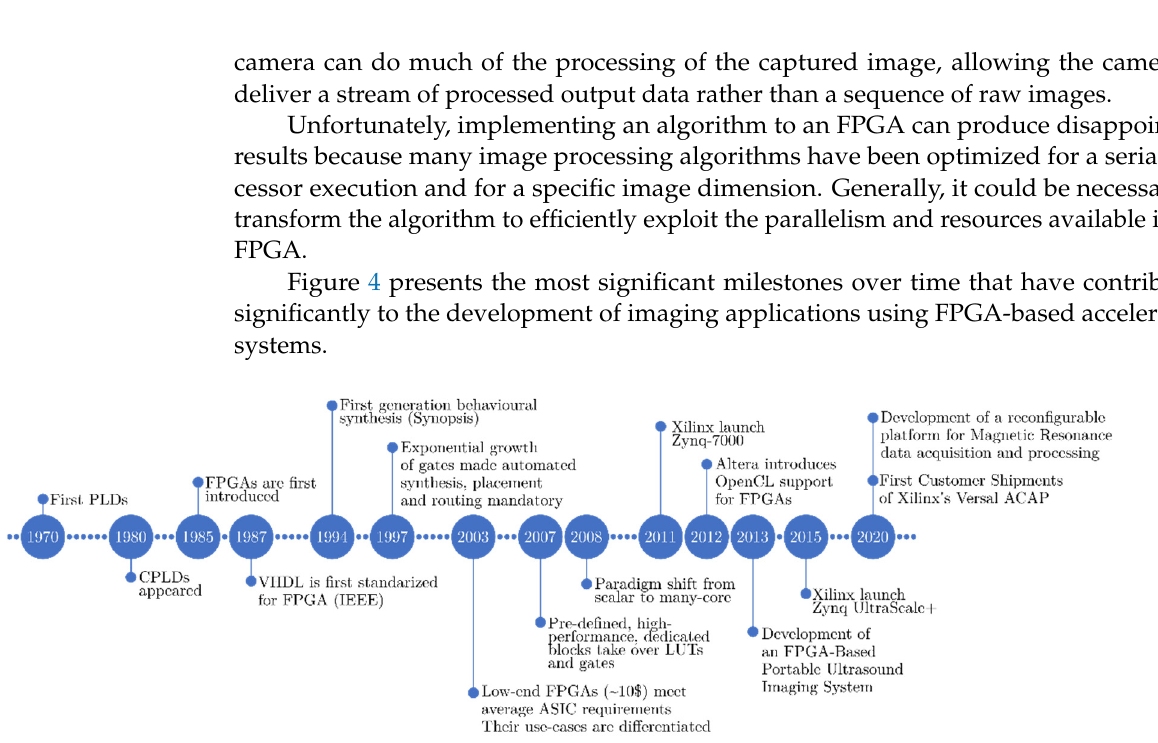
Figure 4. Most significant milestones over time on FPGA-based hardware acceleration for image processing.